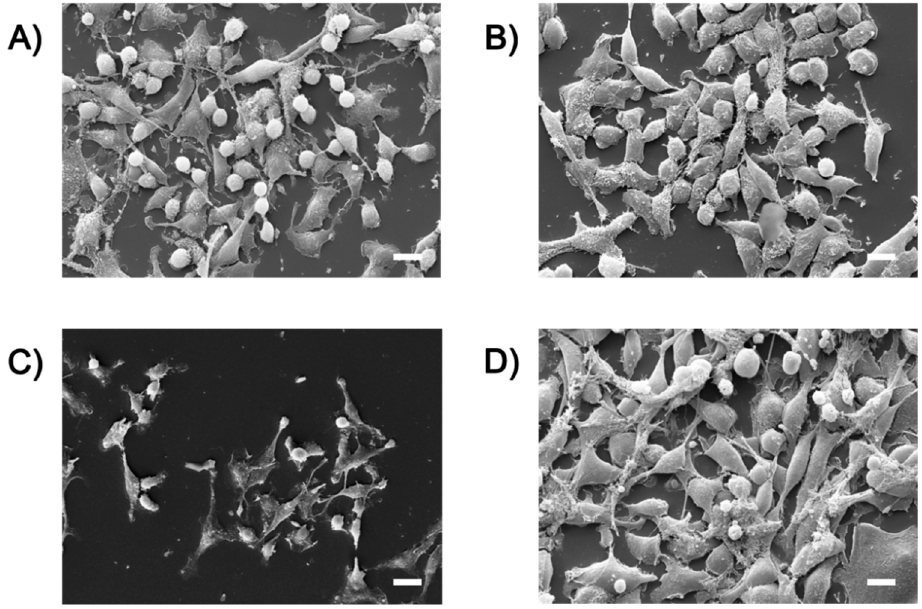
Figure 8. SEM images of ( A ) LoVo cells alone (control) and LoVo cells exposed for 48 h to ( B ) FA, ( C ) NaBu alone and ( D ) NaBu and FA. Scale bar 10 μ m.